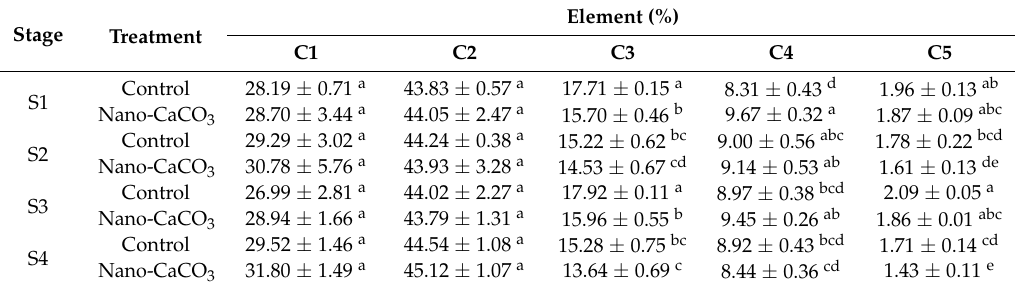
Table 2. Analysis of C1s peaks of cell walls in P. lactiflora inflorescence stems.